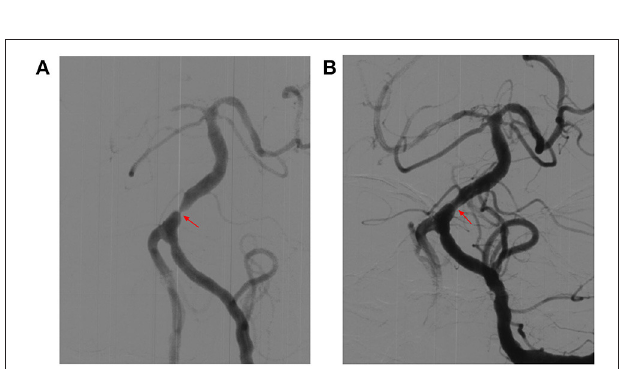
FIGURE 2 | Representative images of cases of basilar artery (BA) before and after stenting (Gateway-Wingspan system). (A) Digital subtraction angiography (DSA) revealed severe stenosis of BA before stenting (red arrow). (B) DSA revealed significant improvement in stenosis of BA after stenting (red arrow).